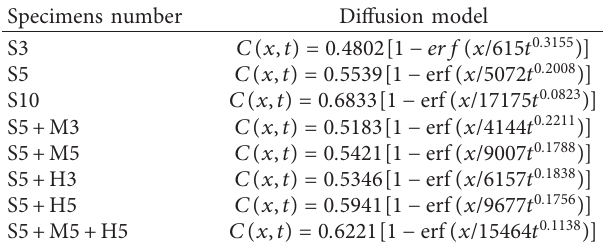
Table 5: The model of diffusion under the composite solutions. Specimens number Diffusion